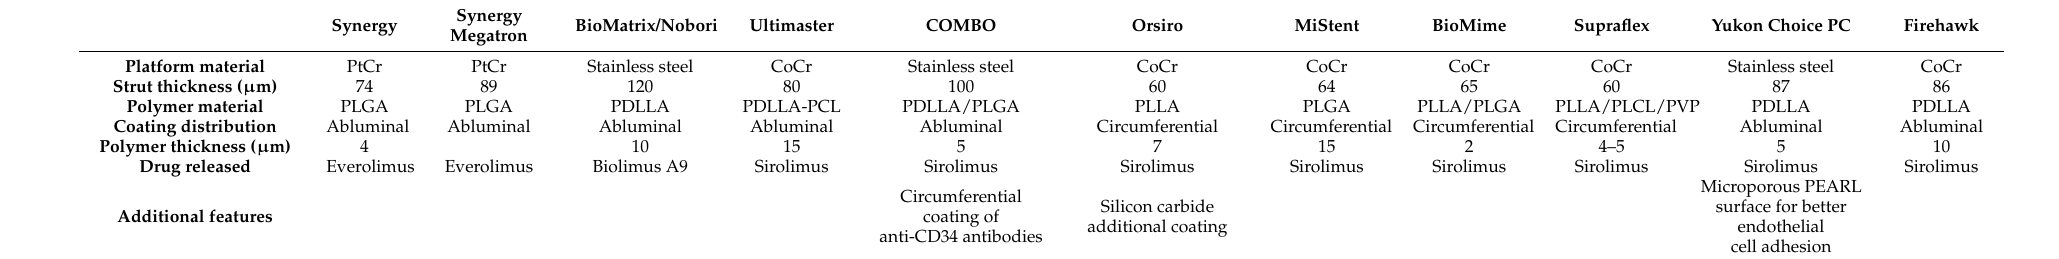
Table 2. Main features of biodegradable polymer drug-eluting stents.